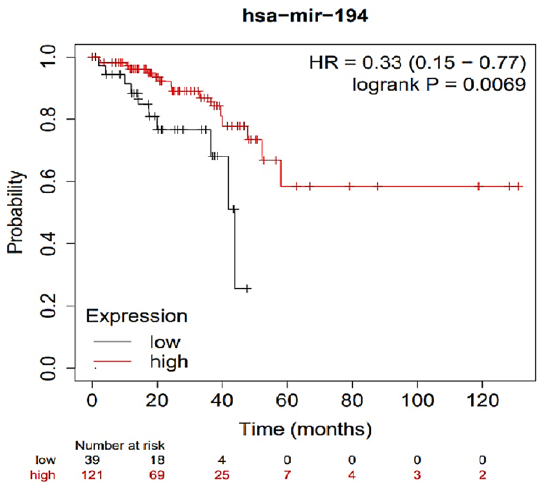
Figure 13. Kaplan–Meier graph of survival analysis has-mir-194. The decrease in the expression of this mir, in proportion to the increase in its expression, decreases the probability of survival more strongly. and ( p value < 0.05).